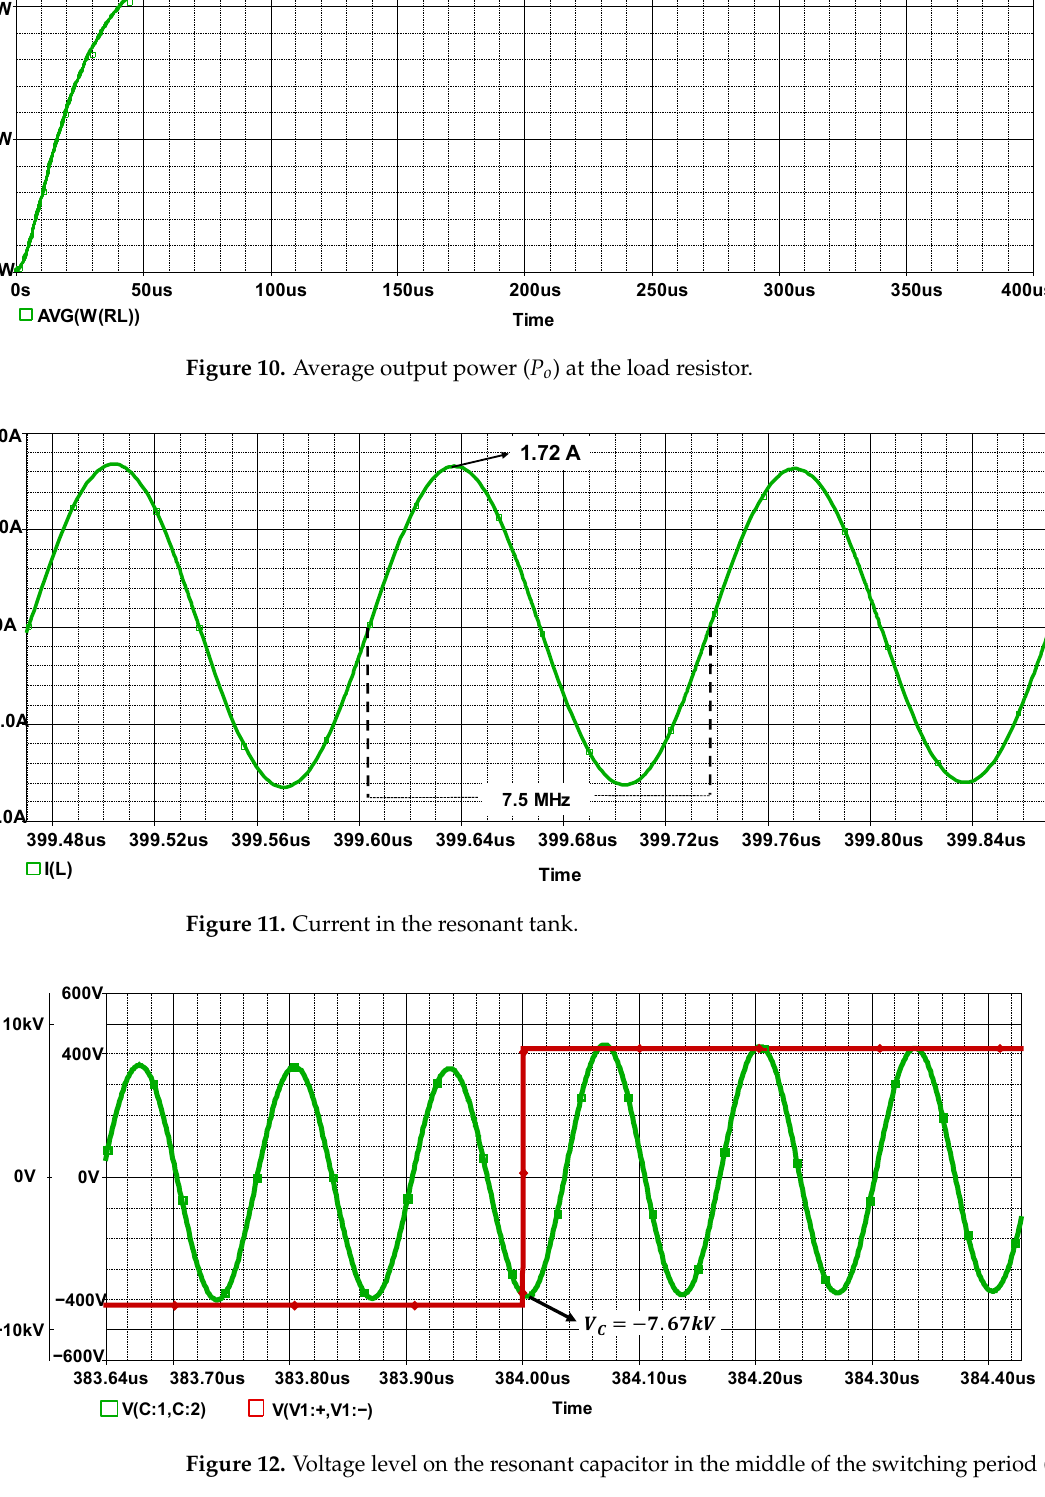
Figure 12. Voltage level on the resonant capacitor in the middle of the switching period ( V C = cV DC ) .